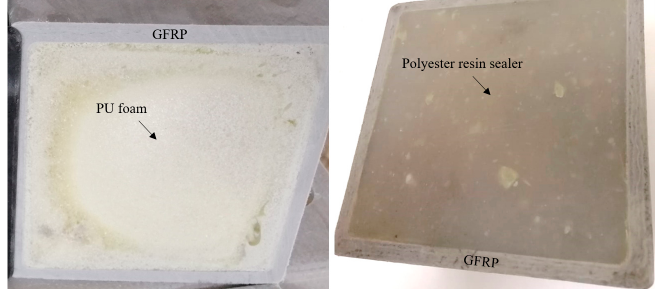
Figure 3. Hollow crossarm sample filled with closed ‐ cell foam, sealed with resin sealer.